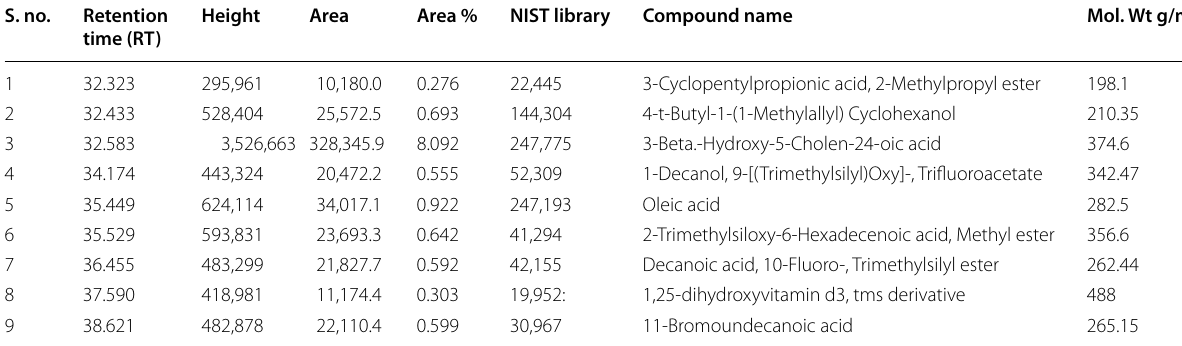
Table 3 GCMS library search for E. indicum (aqueous extract) S. no.